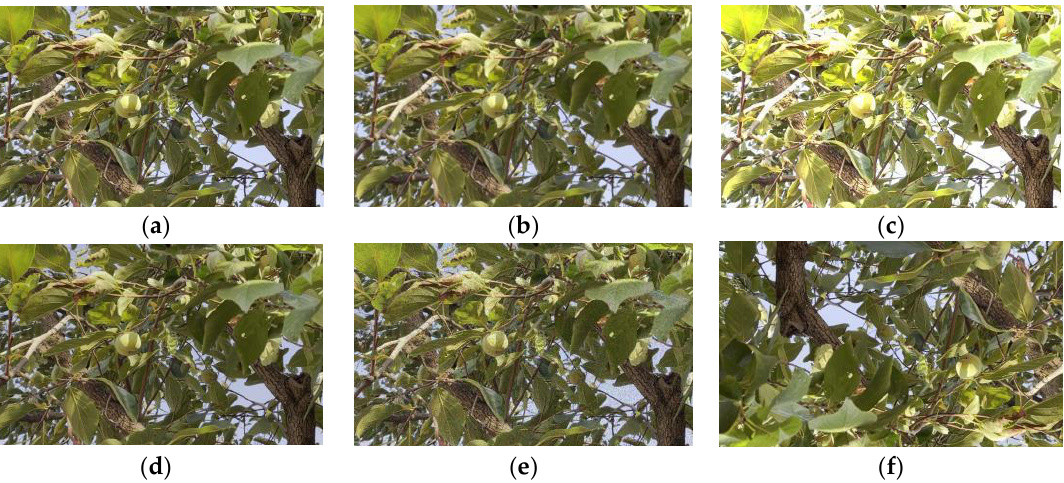
Figure 4. The enhancement effect on a persimmon image: ( a ) original image; ( b ) sharpness reduction; ( c ) brightness enhancement; ( d ) brightness reduction; ( e ) added noise; and ( f ) flip.